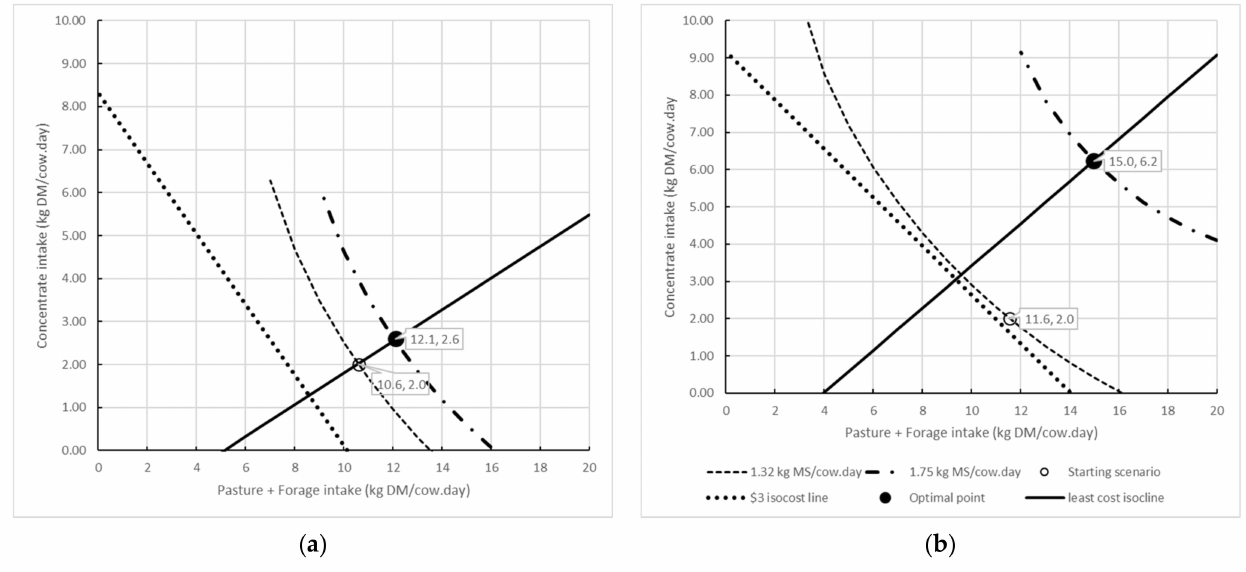
Figure 3. Isoquants representing the starting scenario (- - -) and optimal input combination ( - · - · - · ), least cost isocline (—), isocost line with $3/cow · day financial constraint ( ···· ), starting scenario (o) and optimal input combination ( • ) for the ( a ) spring and ( b ) autumn